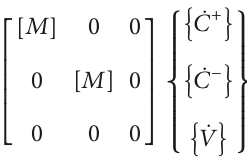
2 depends on the number of